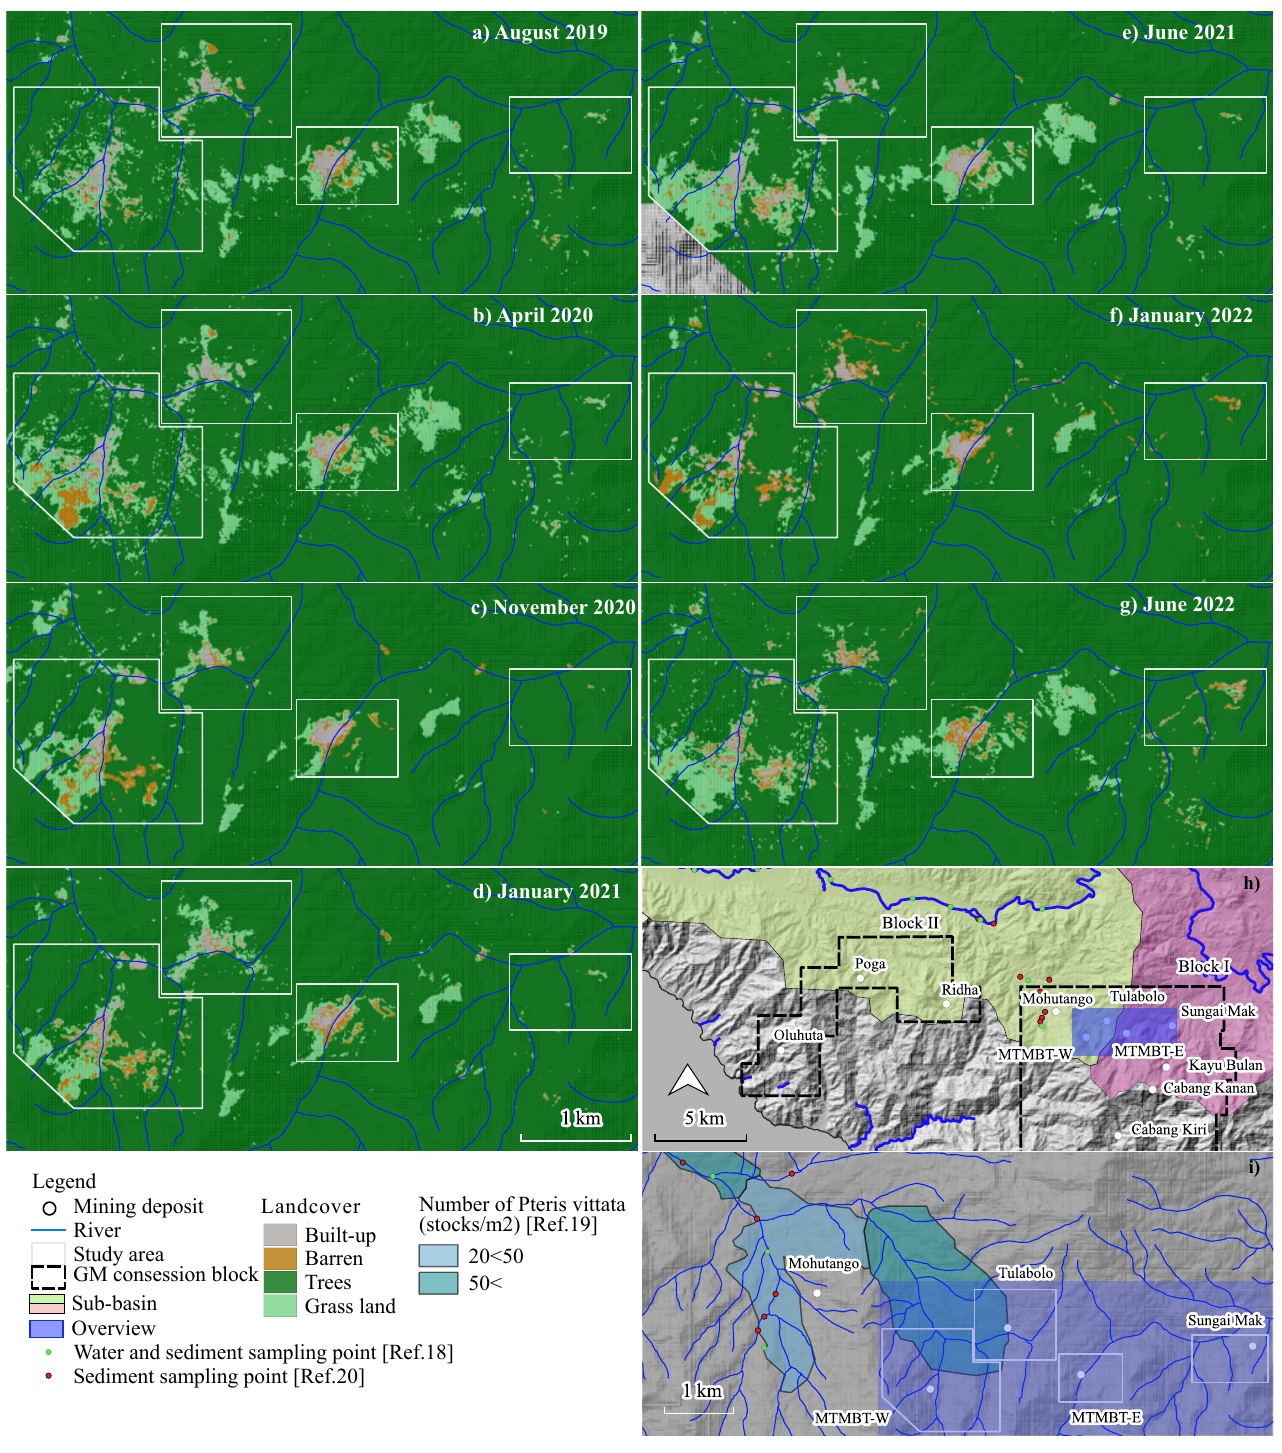
Figure 5. Landcover classification using PlanetScope series; (a–g) landcover transformations in the coexisting mining site (2019–2022); (h and i) overview of the target area.